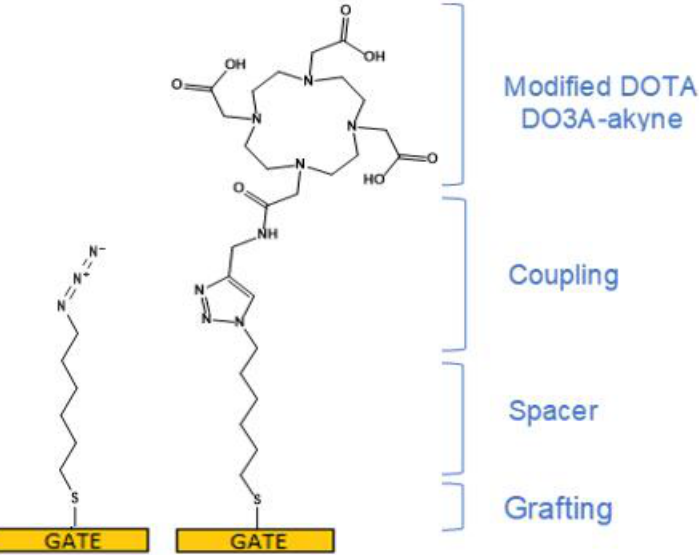
Figure 2. Immobilization scheme of DO3A-alkyne on a Gold gate surface. First, a C 6 alkylthiol (1-azido-6-thiohexane) was immobilized on the Au surface ( left ) then coupled with Product 7 (DO3A- alkyne) through the copper-catalyzed azide-alkyne cycloaddition ( right ) [26].